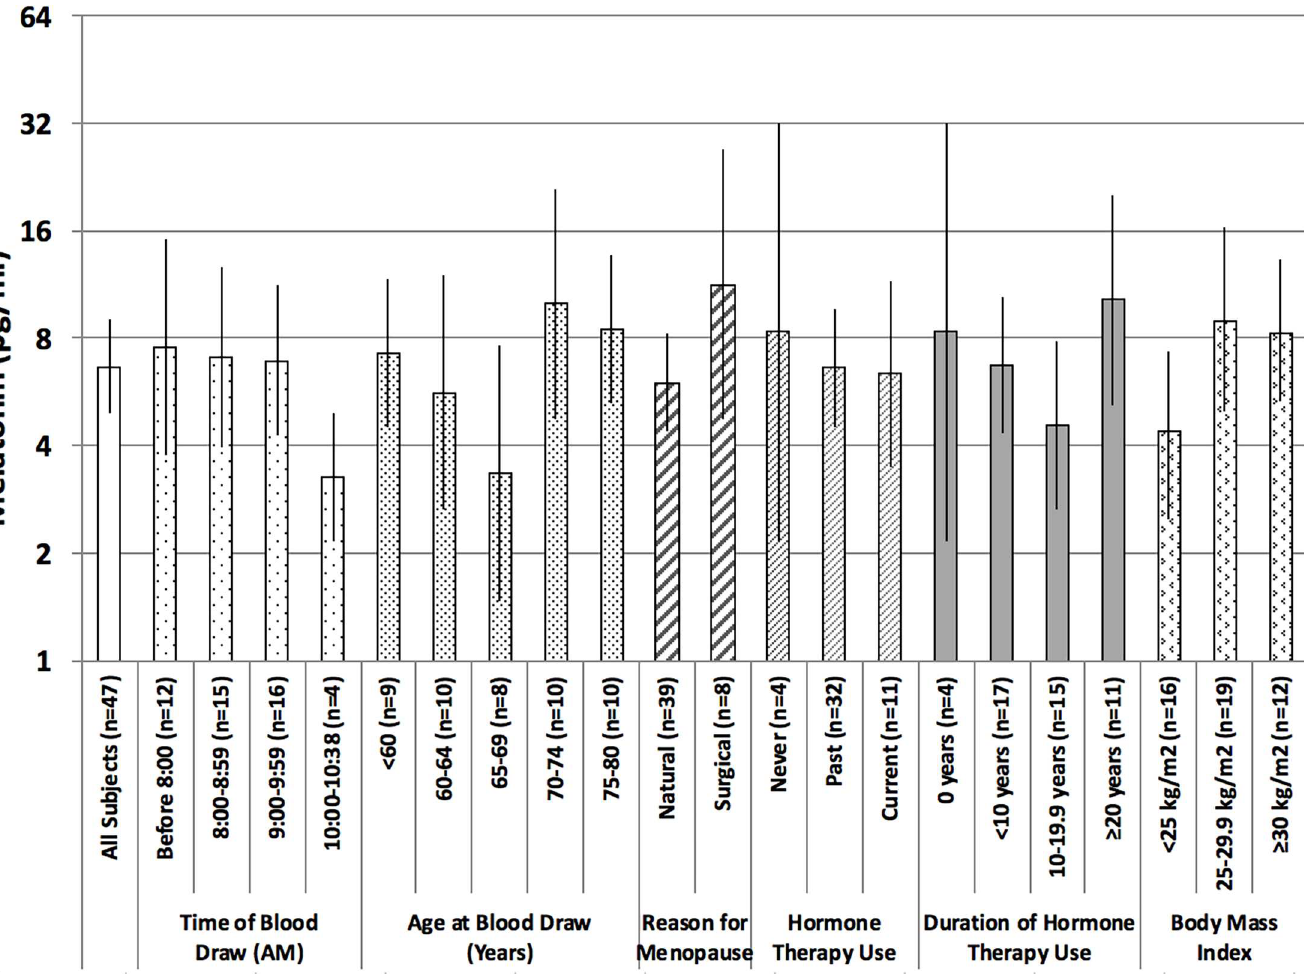
PLOS ONE | https://doi.org/10.1371/journal.pone.0195666 April 11,